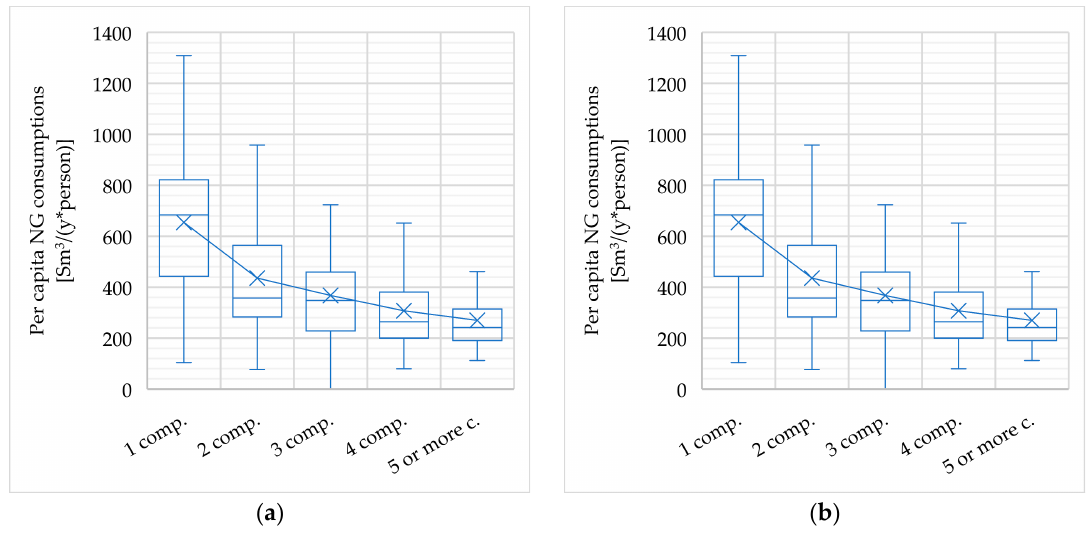
Figure 5. Per capita consumptions; ( a ) Natural Gas; ( b ) Electricity.